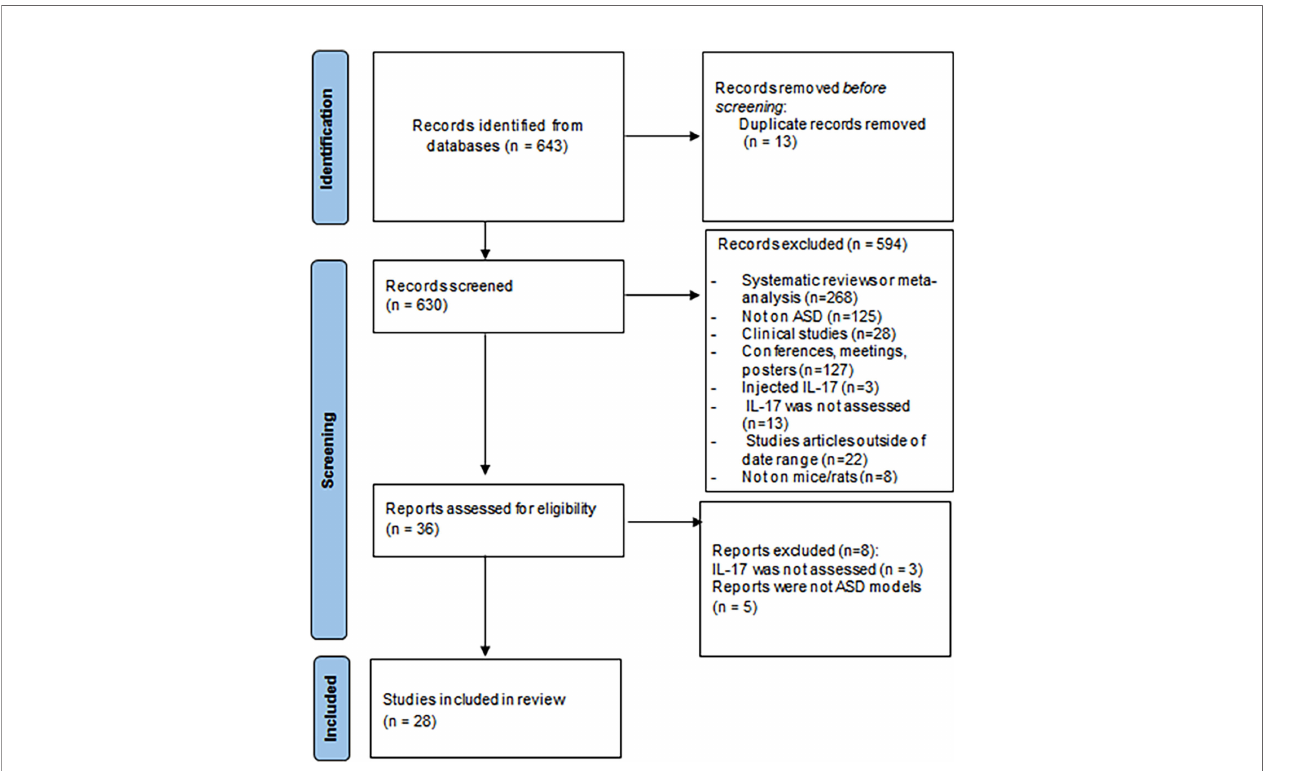
FIGURE 1 | Preferred Reporting Items for Systematic Reviews and Meta-Analyses (PRISMA) fl